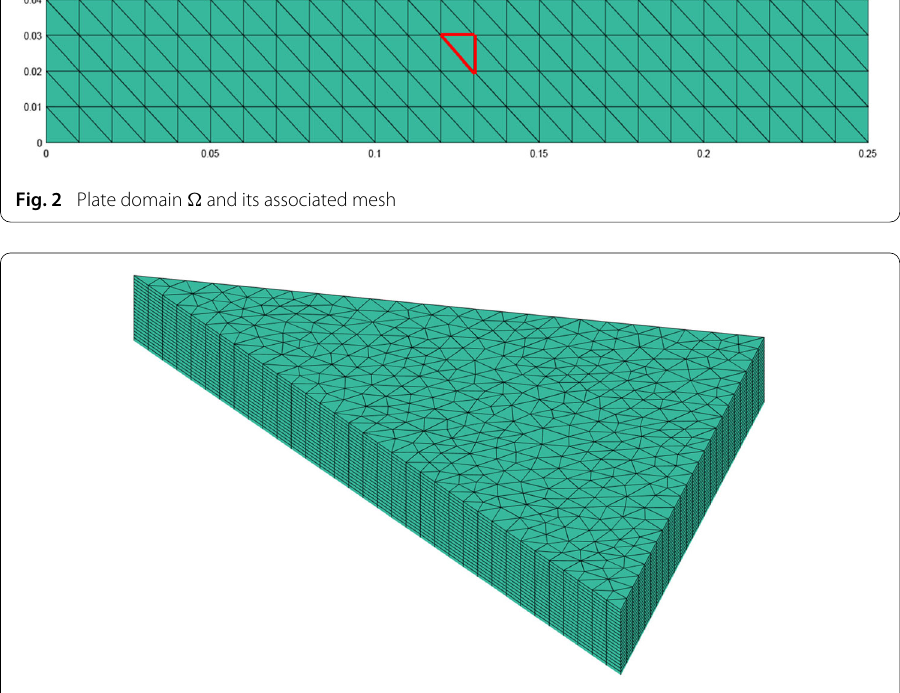
Fig. 3 3D mesh of element (cid:2)